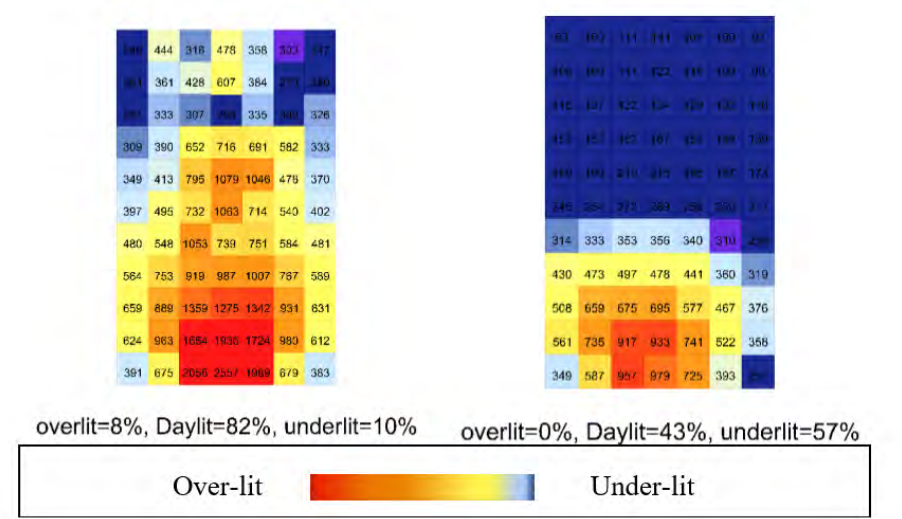
Figure 6. A daylight simulation using DIVA plug-in (source: El-Dbaa, 2016)